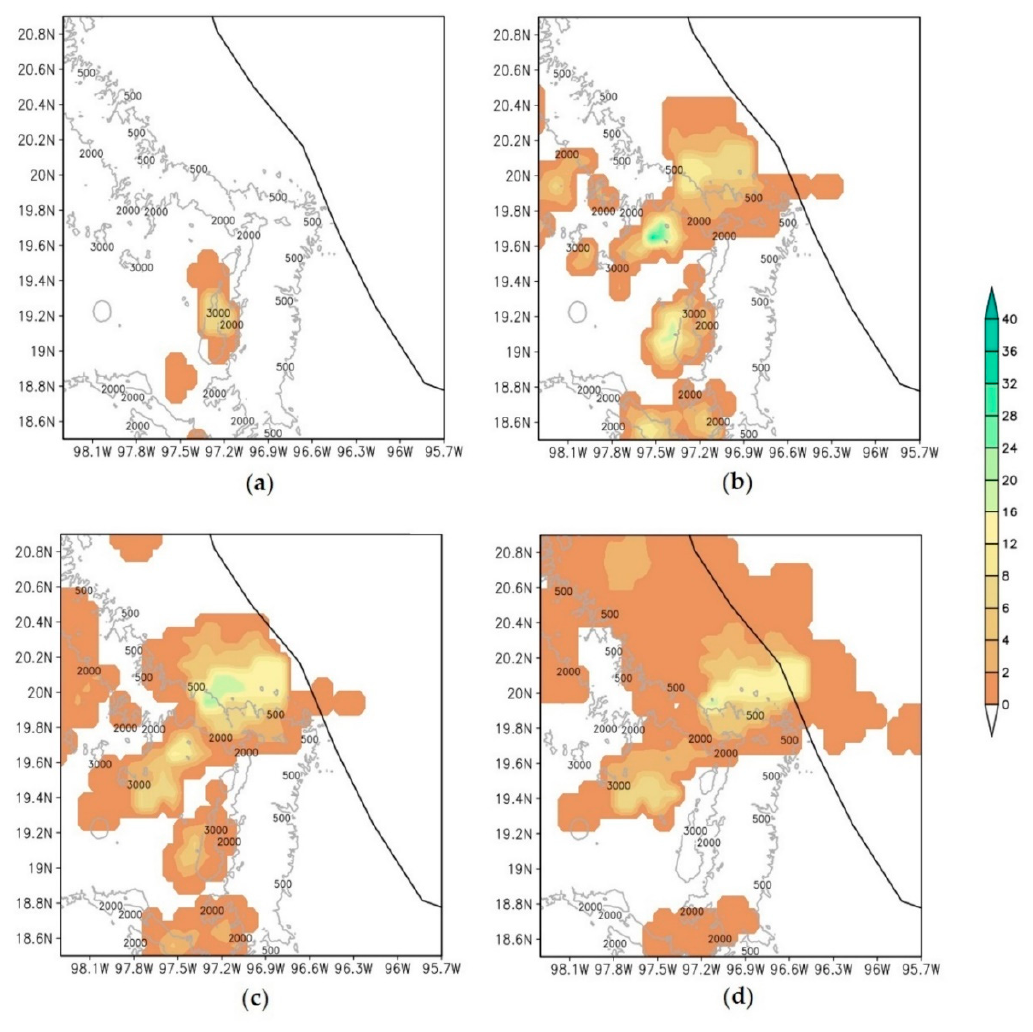
Figure 12. 8-km CMORPH (8-km spatial resolution) rainfall (mm h − 1 ) at: ( a ) 15 LT, ( b ) 16 LT, ( c ) 17 LT, and ( d ) 19 LT by 30 June 2015. The contours of 500 and 2000 m.a.s.l. are shown. On the other hand, on 1 July the rainfall values increased in the Gulf of Mexico during the early − 1 − 1 morning (Figure 13); from 12 mm h at 01 LT to 40 mm h at 03 LT, disappearing at 05 LT. This